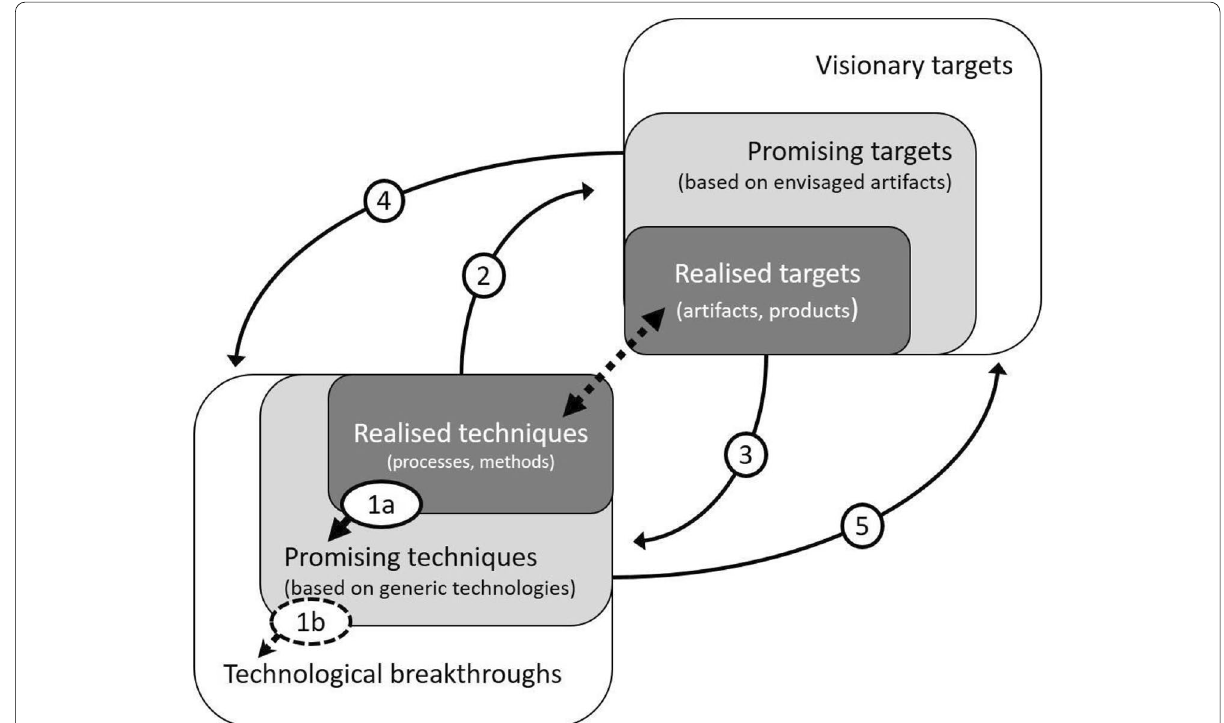
Fig. 4 Technology generalisations as interaction processes of technology push and demand pull (modified from